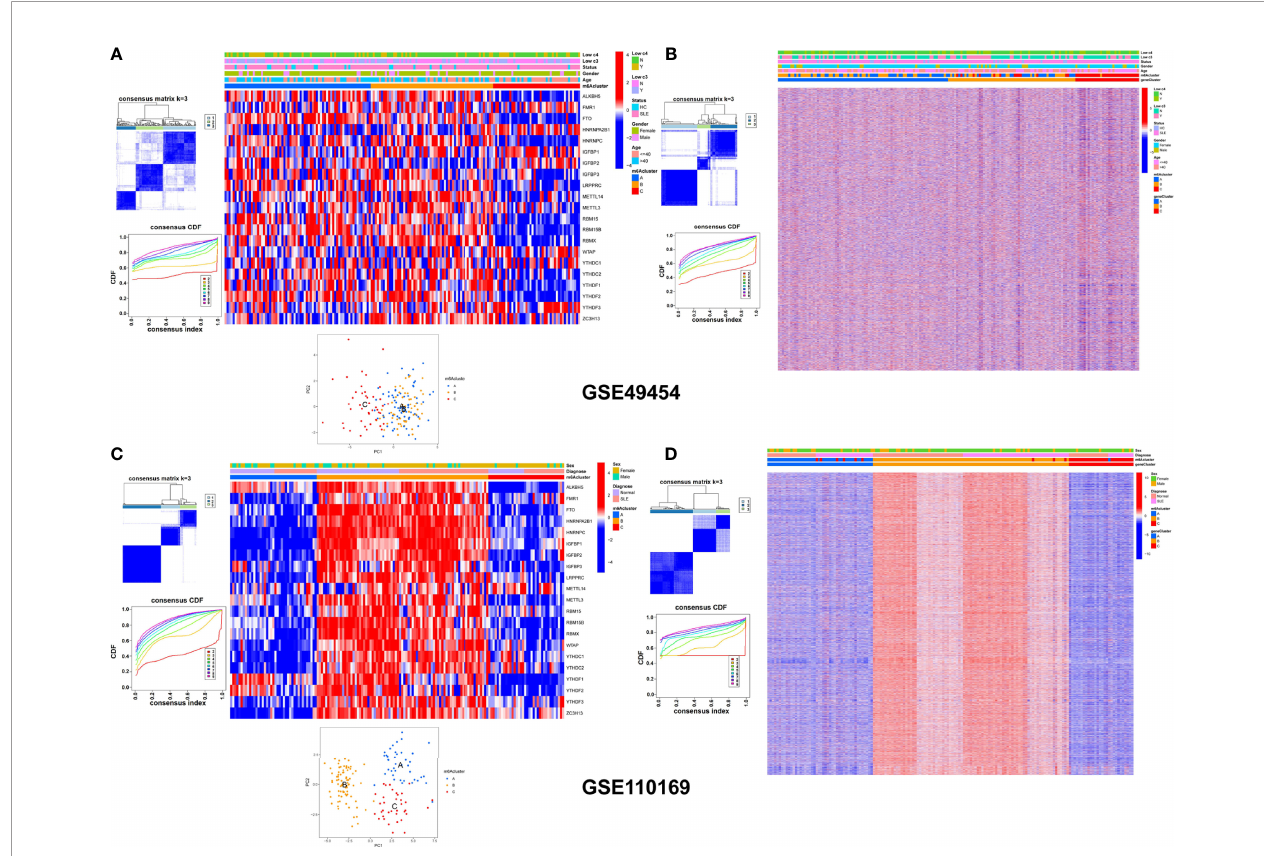
FIGURE 5 | Unsupervised clustering of cohorts based on the genes and m6A clusters. (A – D) Consensus clustering classi fi ed SLE into three gene clusters and three m6A clusters in the GSE49454 (A, B) and GSE110169 (C, D) datasets. The upper columns consist of age, sex, low c3, low c4, and m6A clusters of